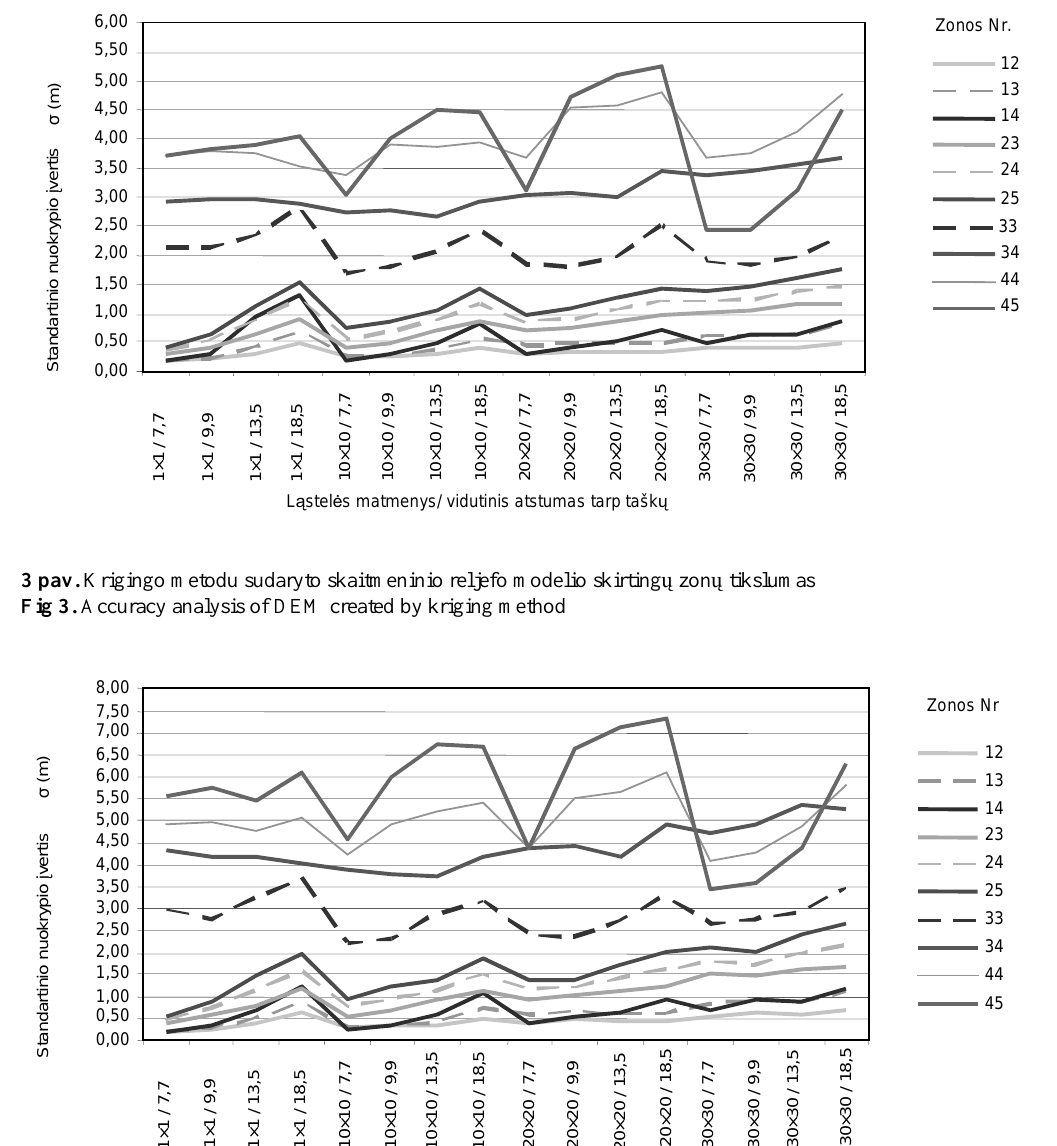
Fig 4. Accuracy analysis of DEM created by spline